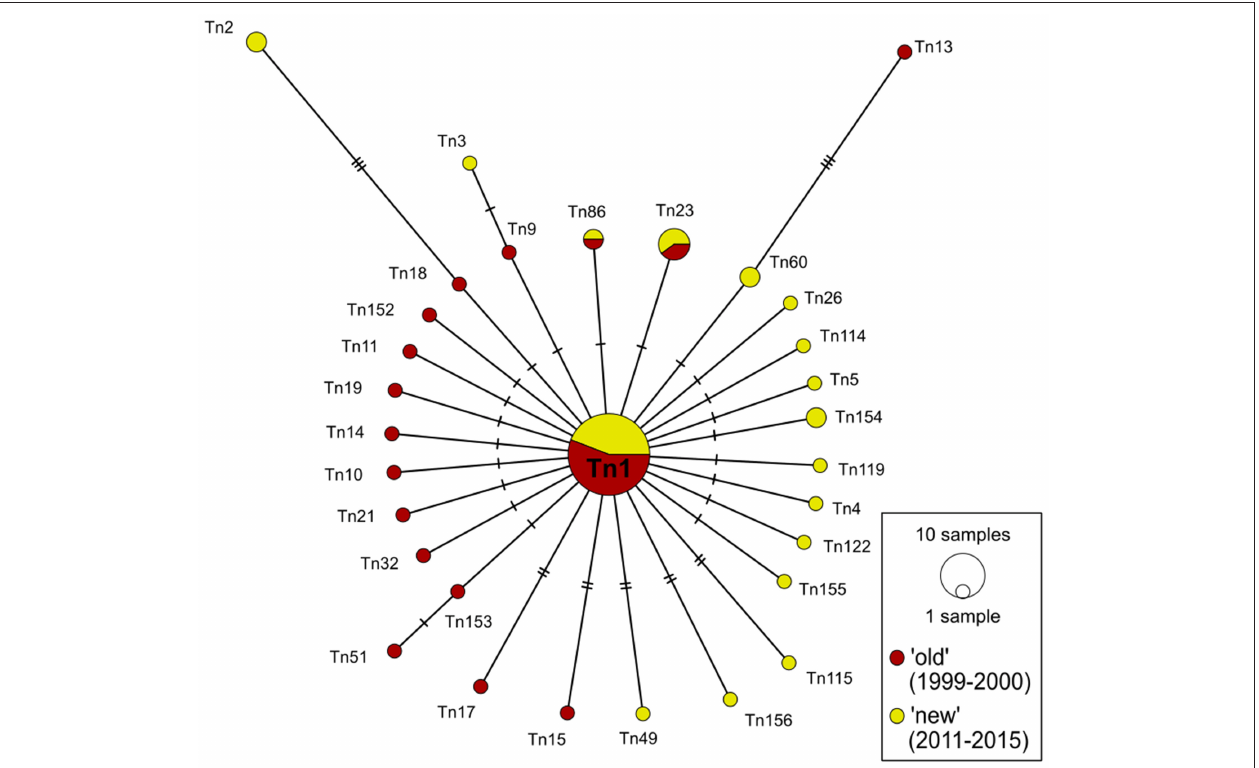
FIGURE 3 | COI haplotype network of DS 2 ( n = 72) based on median-joining analysis. Each circle represents a different haplotype. The size is proportional to the number of individuals sharing the same haplotype. Small black dots are median vectors indicating not sampled or missing haplotypes. Short black bars correspond to the number of mutation steps between the haplotypes (one to